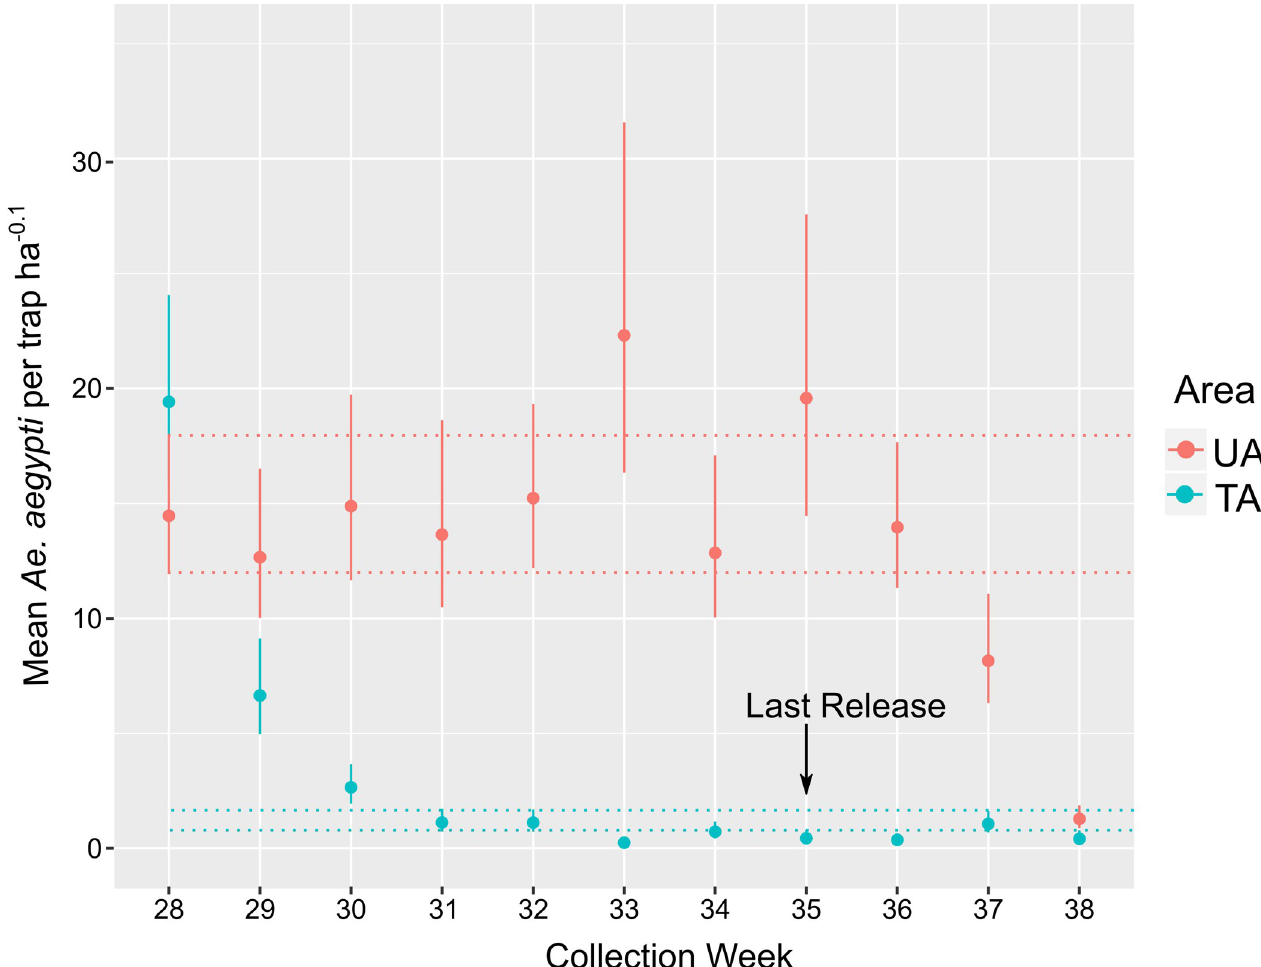
Fig 4. Relative abundance of Ae . aegypti females per week in the untreated and treated area. The center dot denotes the most probable value. Error bars denote 95% credibility intervals (see the “Statistical Methods for Abundance Estimation” section for description of the mean and credibility intervals). Red dotted line represents the credibility interval for the UA abundance in week 28. Blue dotted line represents the credibility interval for the TA abundance in week 31. If the credibility intervals do not overlap the means are considered statistically different with a probability of 95%.